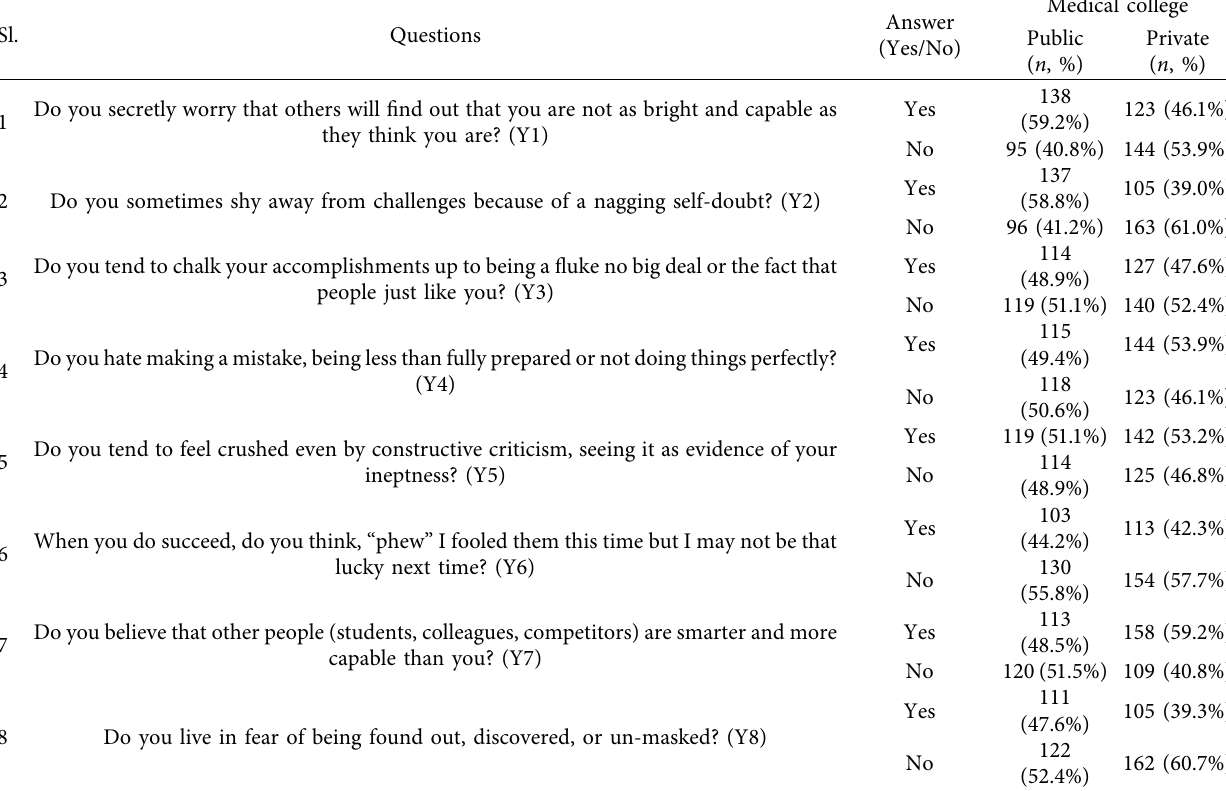
Table 1: Answers to imposter syndrome questions by medical college students according to the Young Imposter Syndrome scale. Sl.